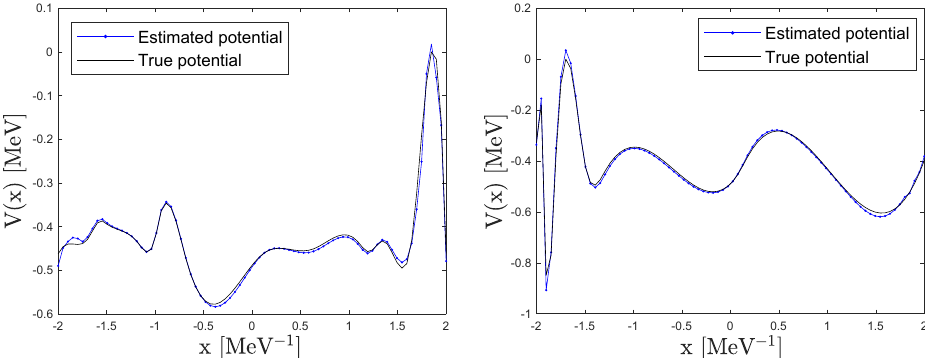
Figure 13. Comparison of the true potential and the estimated potential for two different configu- rations, calculated by the identified 4th order Volterra model, including the first-order cross kernel H 1 {(cid:60){ Ψ ( x ) } , (cid:61){ Ψ ( x ) }} , with M = 5